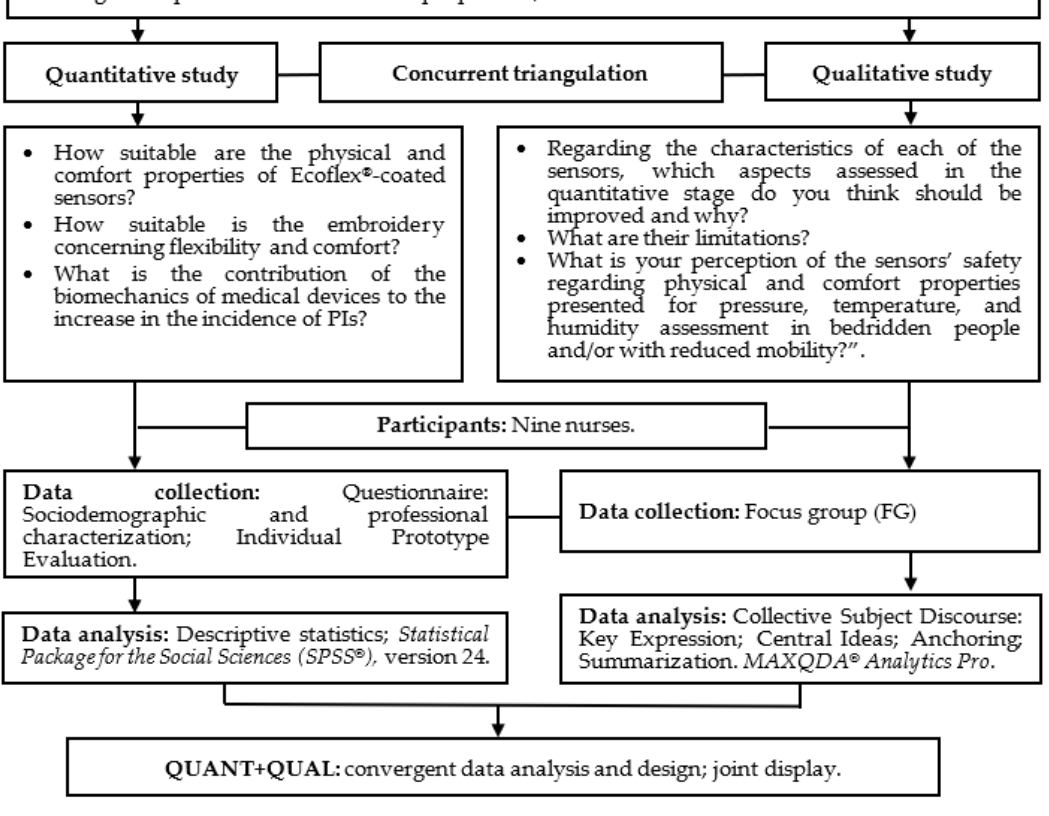
Figure 1. Representative diagram of the mixed method study design. Coimbra, Portugal, 2022. Note: QUANT: quantitative; QUAL: qualitative.